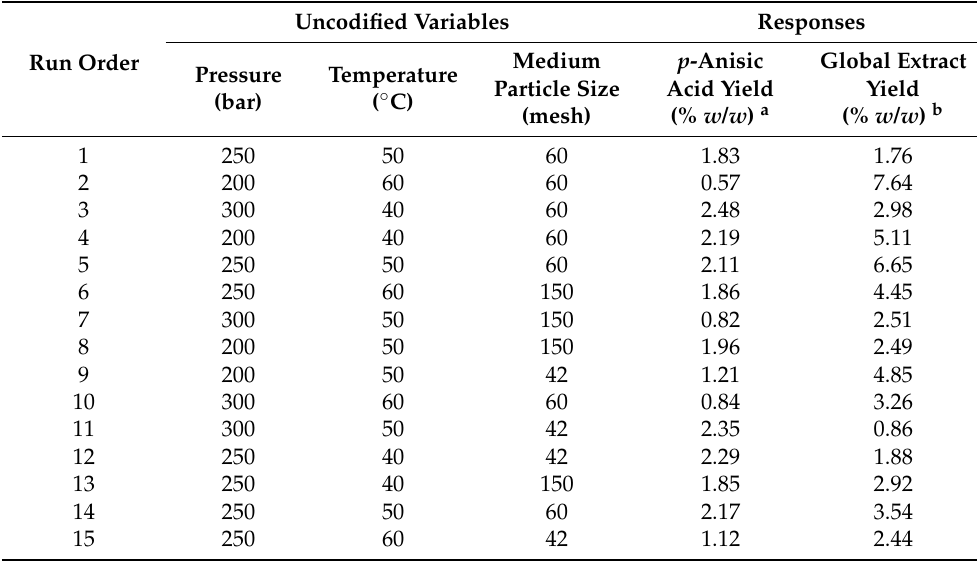
Table 3. Design matrix in the Box–Behnken model and observed